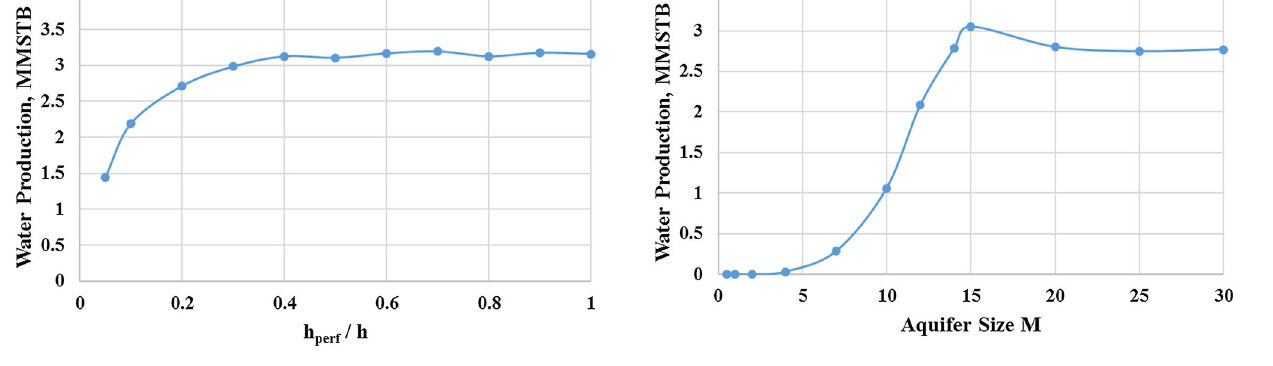
Fig. 28 Total water production for different aquifer